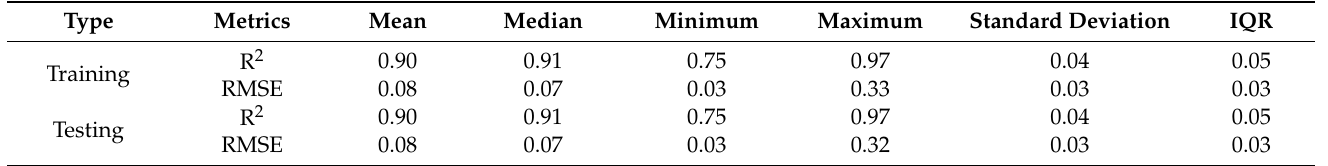
Table 4. Summary of the test performances for daily imputation models.